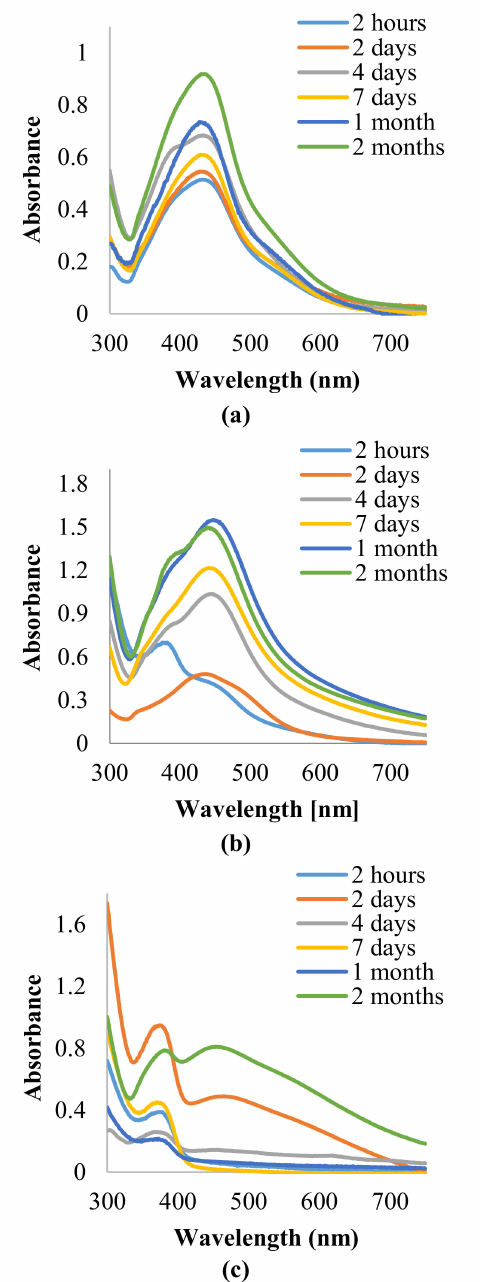
Figure 2. Absorption spectra of AgNPs prepared with the use of a C. incanus leaves infusion ( a ) 5 mL, ( b ), 10 mL, ( c ) 15 mL recorded at various time